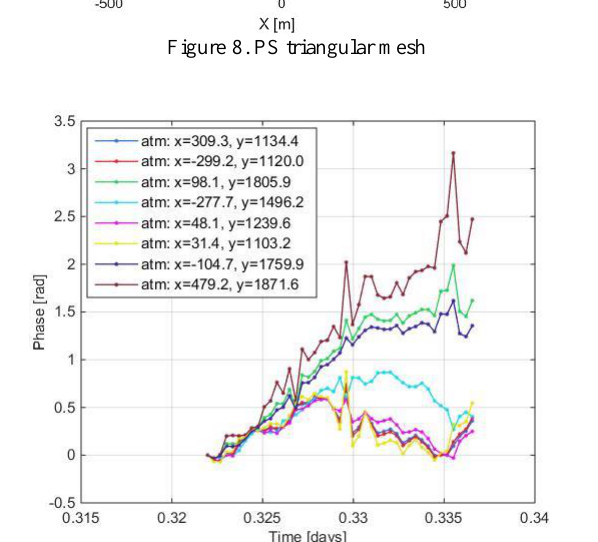
Figure 8. PS triangular mesh